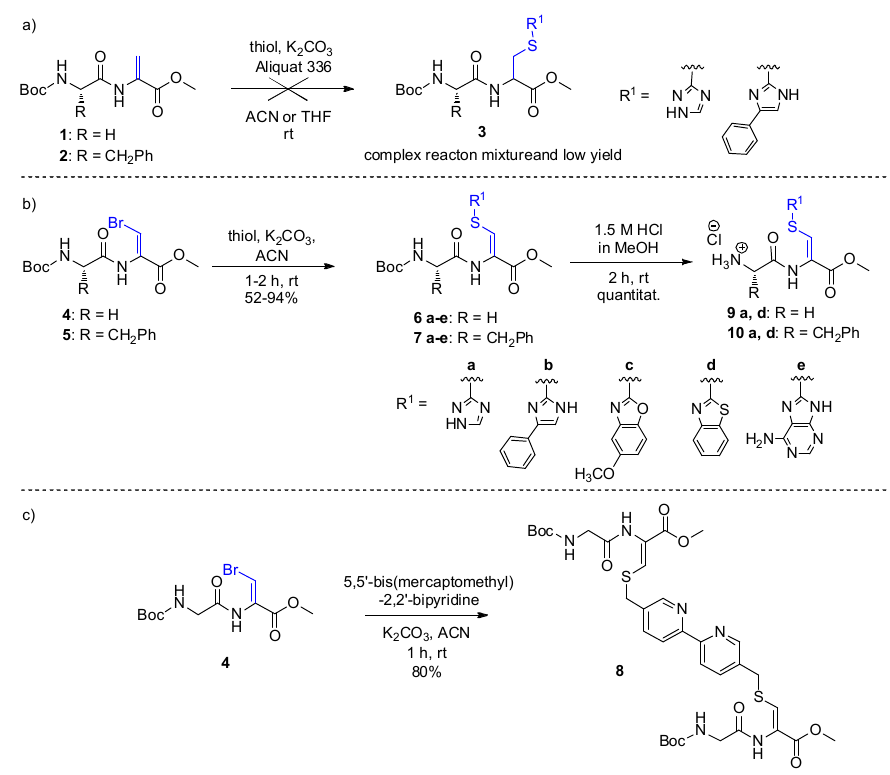
Scheme 1. Syntheses of dipeptide building blocks containing ( a ) C -terminal cysteines; ( b ) C -terminal dehydrocysteines; ( c ) cross-linked